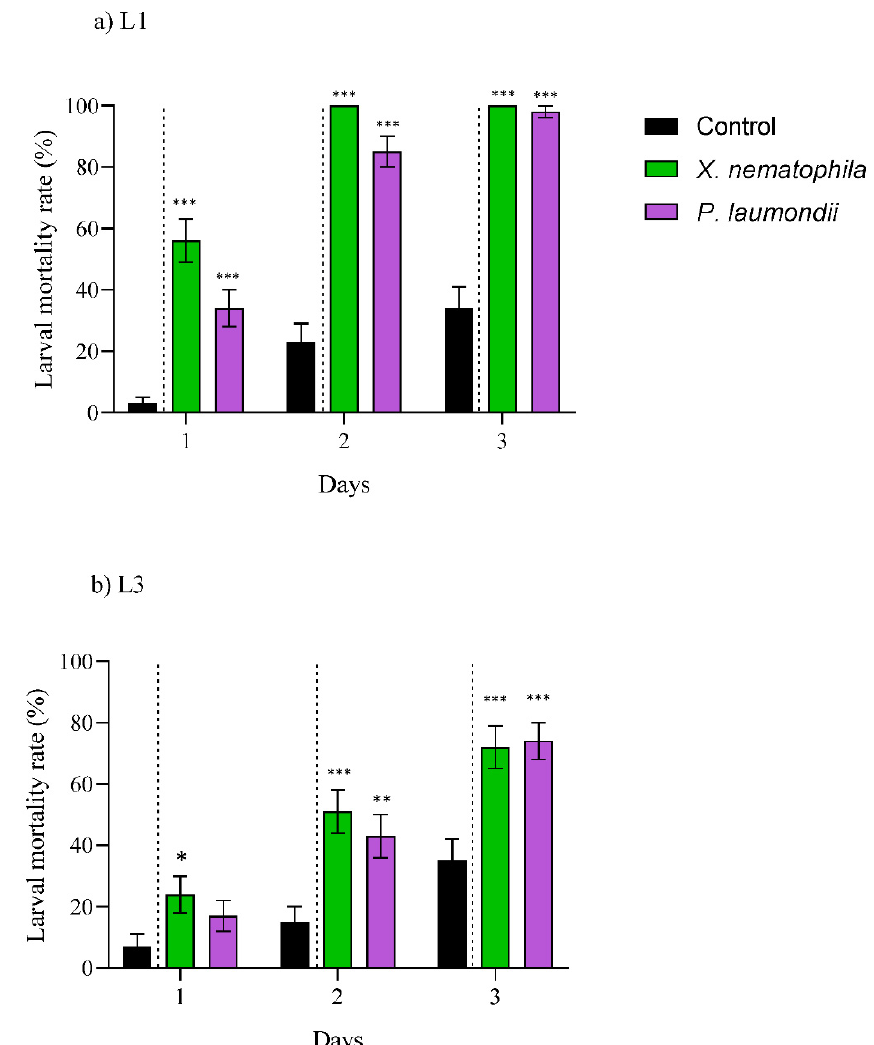
Figure 3. Toxic effect of the natural products produced by the symbiotic bacteria Xenorhabdus nematophila and Photorhabdus laumondii present in the unfiltered ferment (UF) against various larval instars the European grapevine moth, Lobesia botrana. ( a ) First instar (L1) and ( b ) third instar (L3). Data are presented in days (from 1 up to 3 days, x-axis) and measured as larval mortality rate (%) (y-axis). Asterisks indicate significant differences at *** p < 0.001, ** p < 0.01, * p < 0.05. Values are least-square means ± SE.